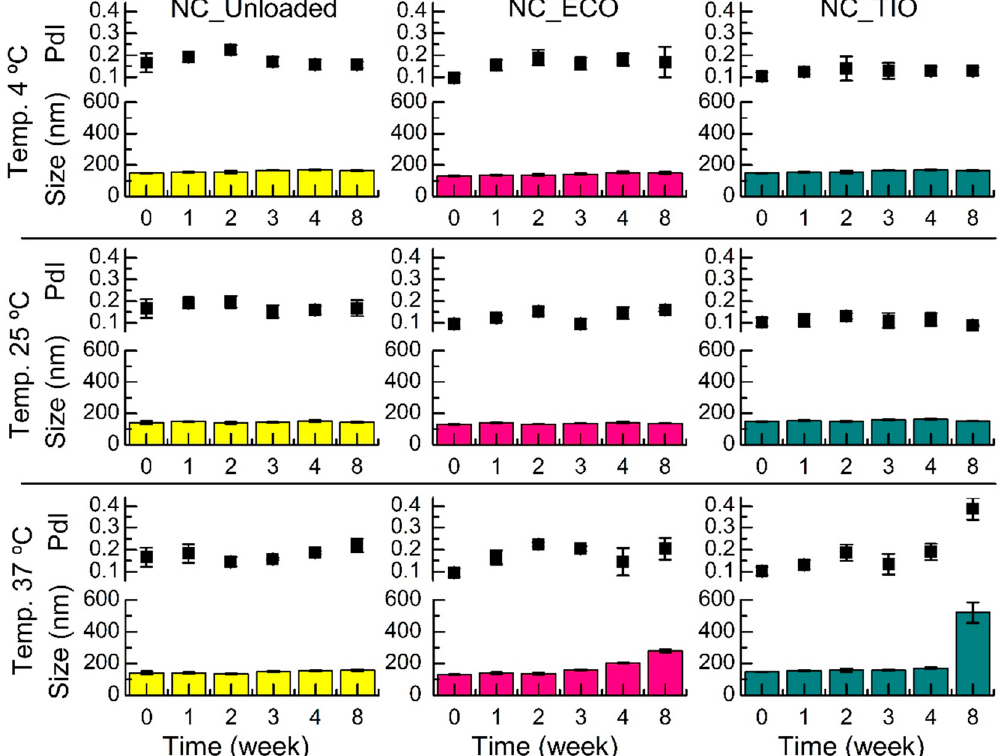
Figure 5. Evolution of size (Z-average diameter) and PdI over time of drug-loaded and unloaded (blank) NC incubated at 4, 25, and 37 °C. Data shown are means ± SD ( n = 3).